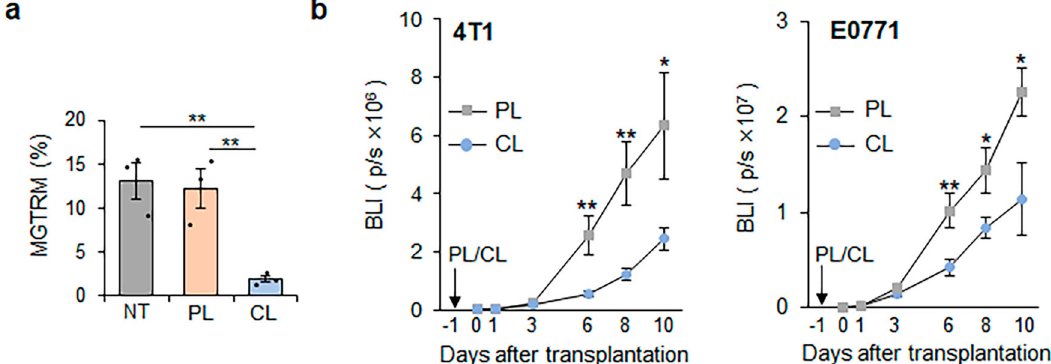
Fig. 3 Effect of MGFP treatment with CL on TNBC growth. a Flow cytometry analysis of CD11b + F4/80 + MGTRMs in BALB/c MGFP 1 day after PL or CL administration (Left). n = 3. NT: untreated. ** p < 0.001( t -test). b Bioluminescence intensity (BLI) of indicated TNBC transplanted 1 day after PL or CL administration at indicated days after transplantation. n = 12 for PL, n = 14 for CL. * p < 0.05, ** p < 0.01 ( t -test). a , b Error bars indicate